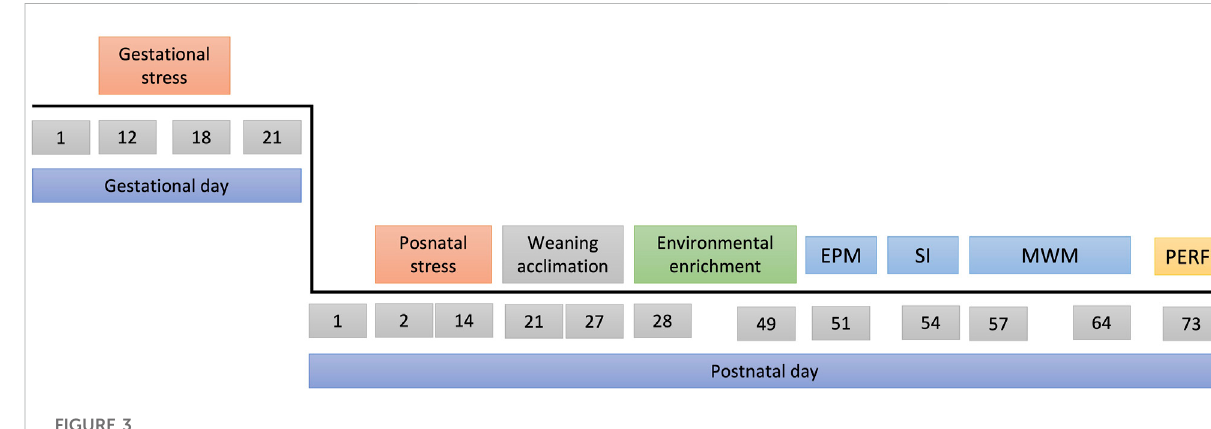
FIGURE 3 Experimental design. Top line: gestational days, bottom line: postnatal days. Abbreviations EPM, Elevated Plus Maze; SI, Social Interaction; MWM, Morris Water Maze; PERF, trans-cardiac